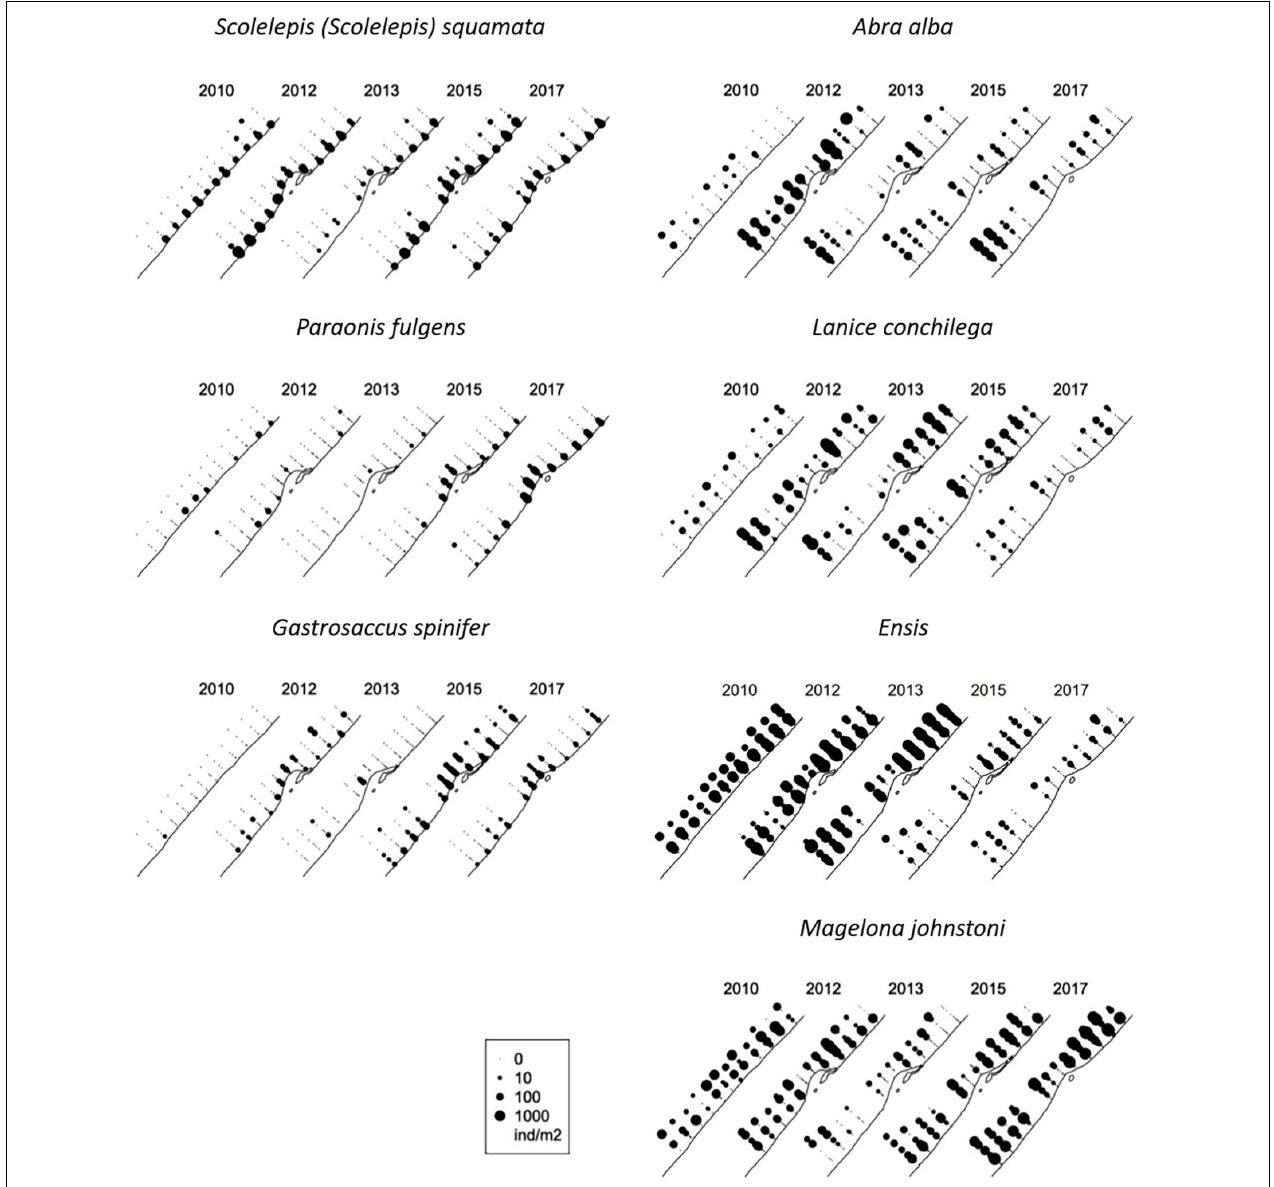
FIGURE 6 | Spatial and temporal variation of the abundance of some species with strong negative scores on the first axis of the PCA (left-hand column) and with strong positive scores (righthand column). The radius of the dots is proportional to the logarithm of the abundance in the individual samples; absence is indicated by the smallest